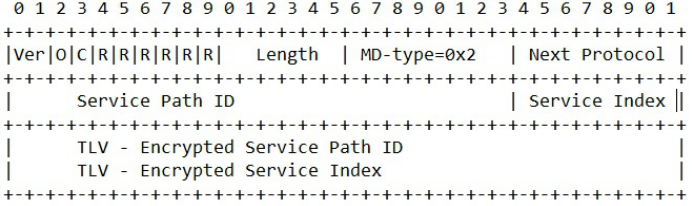
Figure 21. Packet structure in